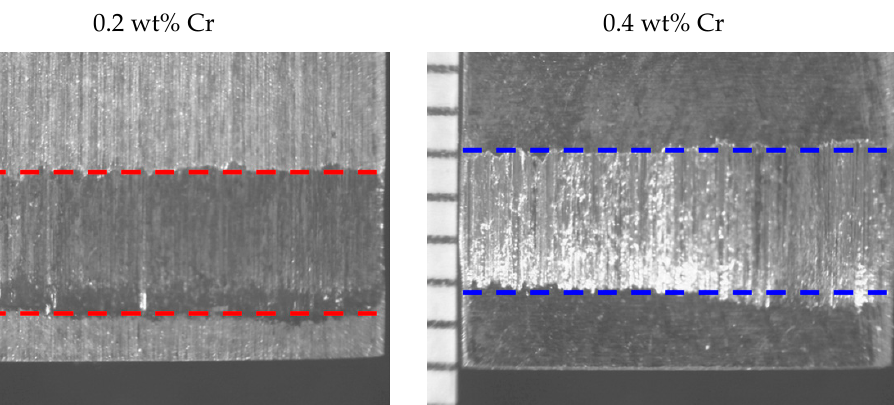
Figure A4. Wear scars samples for DI and CADI alloyed with 0.2 and 0.4% Cr, austempered at 265 and 305 for 90 min. References 1.